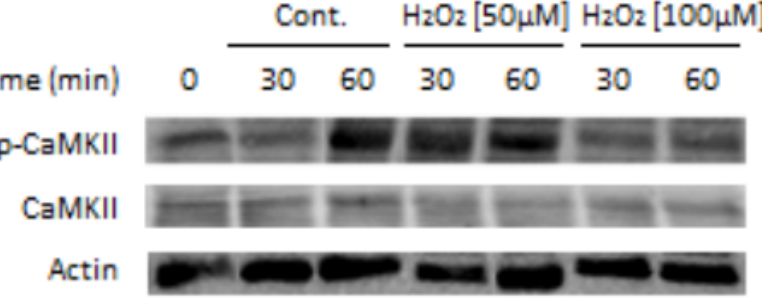
Figure 1. CaMKII phosphorylation/activation is affected by H 2 O 2 : Bovine sperm (1 × 108 cells/mL) were incubated under capacitation conditions (mTALP buffer) for 30 and 60 min in the absence (Cont.) or presence of H 2 O 2 [50 µM, 100 µM]. Proteins were extracted and analyzed by Western blot using anti-phospho-CaMKII (Thr-286) (p-CaMKII), anti-CaMKII (CaMKII), and anti-actin (Actin) (loading control) antibodies. The results shown are representative of three independent experiments. See procedure information in [41].